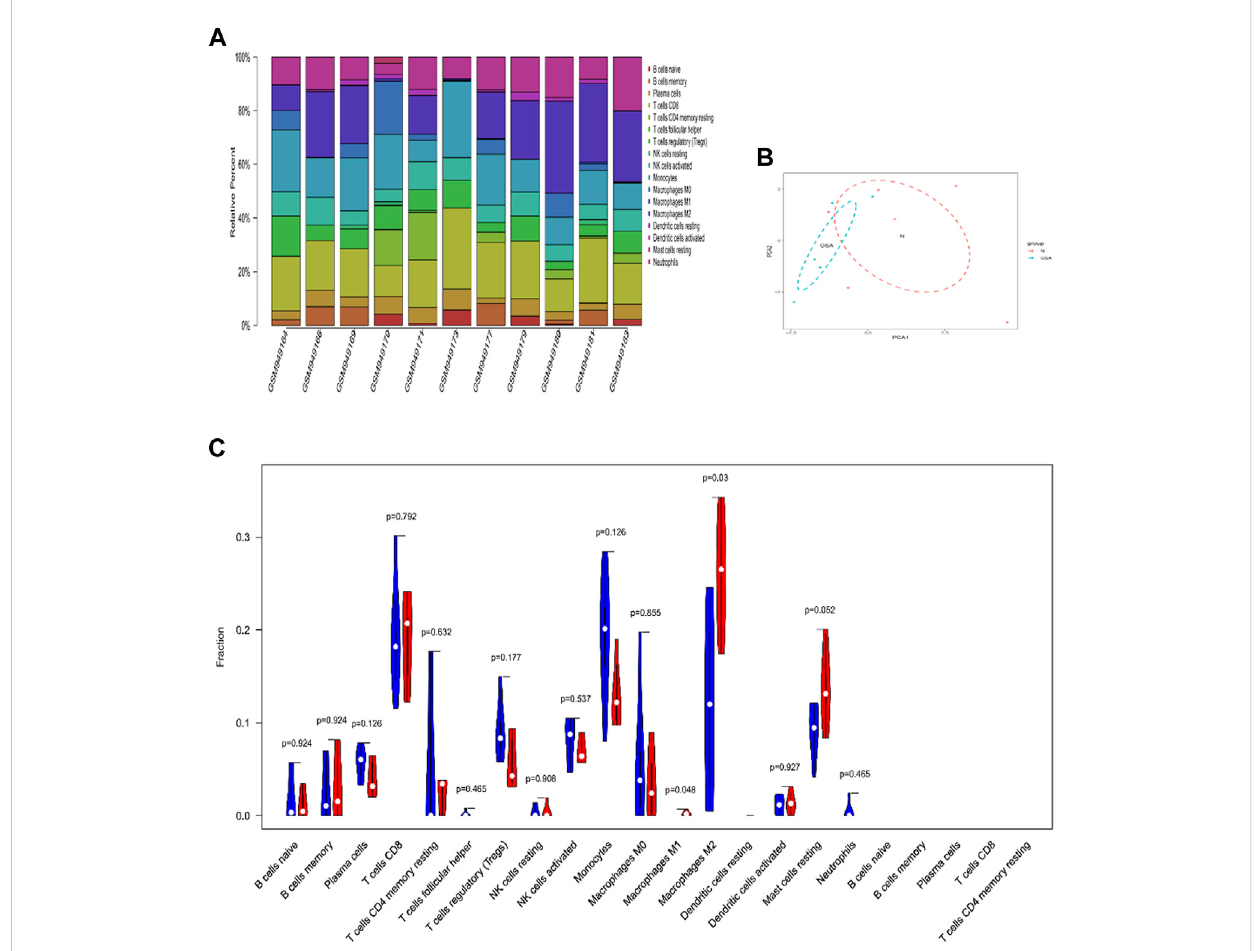
FIGURE 3 The landscape of immune in fi ltration in VAT between OSA and controls. (A) The relative percentage of 22 subpopulations of immune cells in 11 samples from GSE38792 datasets. (B) Principal components analysis performed on all samples. (C) Violin plot of differences in 22 in fi ltrating immune cells between OSA and normal controls. The normal group was marked as blue color and OSA group was marked as red color. p values < 0.05 were considered as statistical signi fi